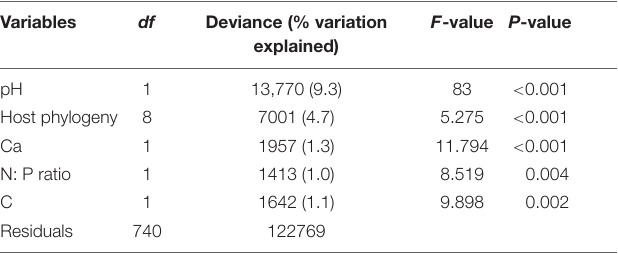
TABLE 1 | Effects of host and abiotic variables on the operational taxonomic unit richness of ectomycorrhizal fungi as revealed by generalized linear model and ANOVA